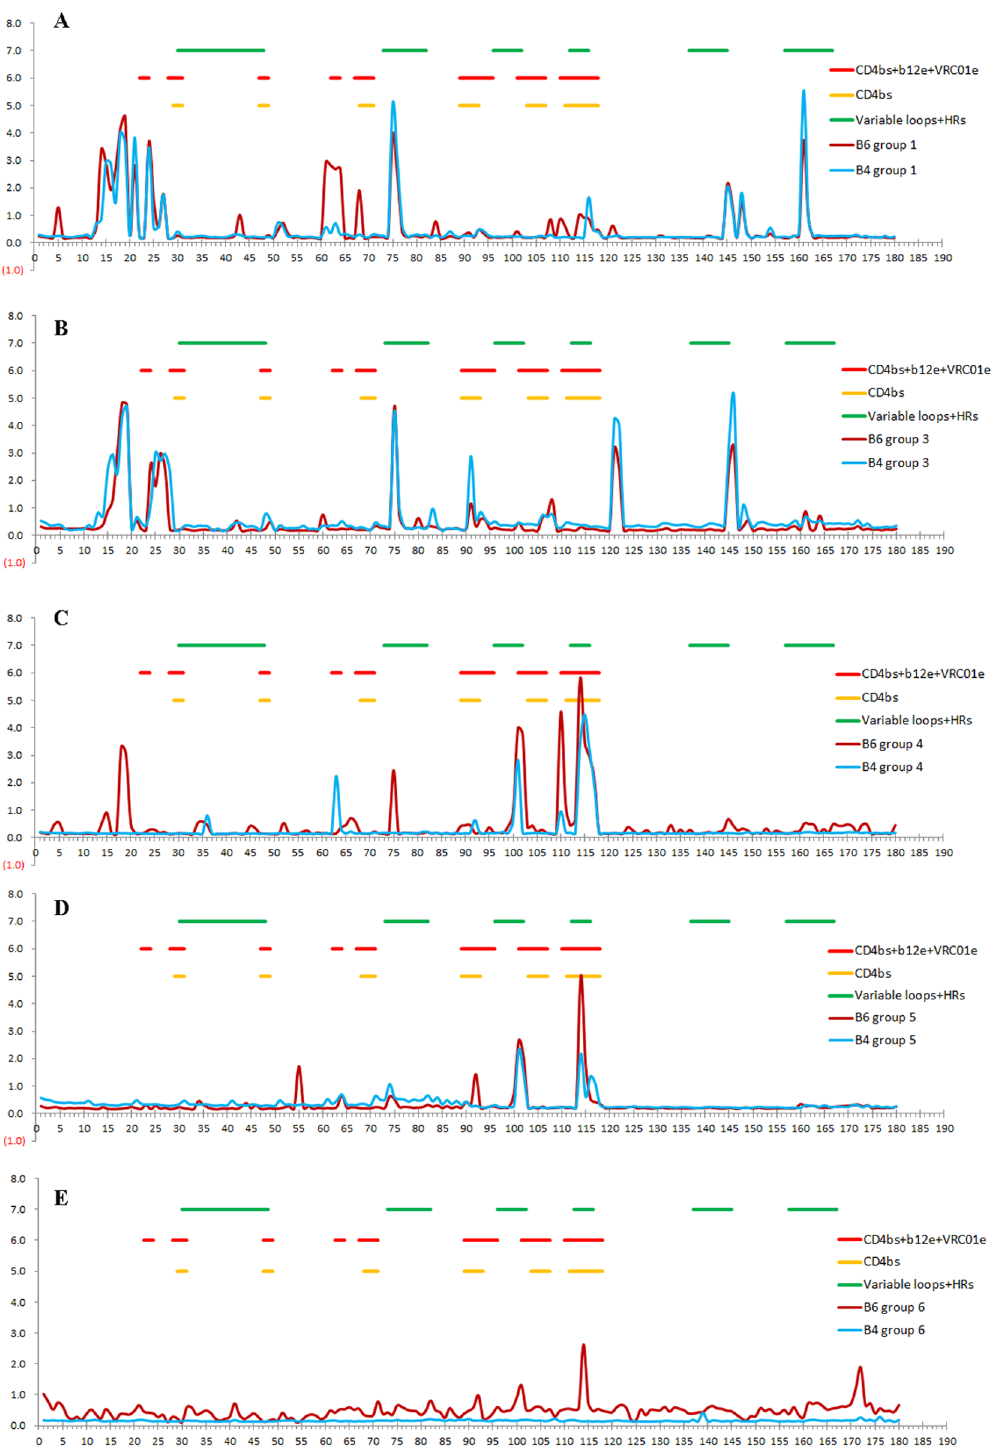
Fig 3. Profiling of bleed 4 and 6 rabbit IgGs from each group with the consensus clade B 15-mer peptides. Profiles of bleed 4 and 6 rabbit IgGs from group 1 (A), 3 (B), 4 (C), 5 (D) and 6 (E) with the consensus clade B 15-mer peptides are shown. Locations of CD4bs peptides, b12 epitope (b12e) and VRC01 epitope (VRC01e), as well as Env variable loops and HR regions (HR1 and HR2) are indicated according to “ Neutralizing Antibody Resources ” (http://www.hiv.lanl.gov/content/immunology/neutralizing_ab_resources.html). Two serum samples from a same group were profiled separately, but the addition results of the two samples from the same group are shown. X axis: position of the peptides. Y axis: